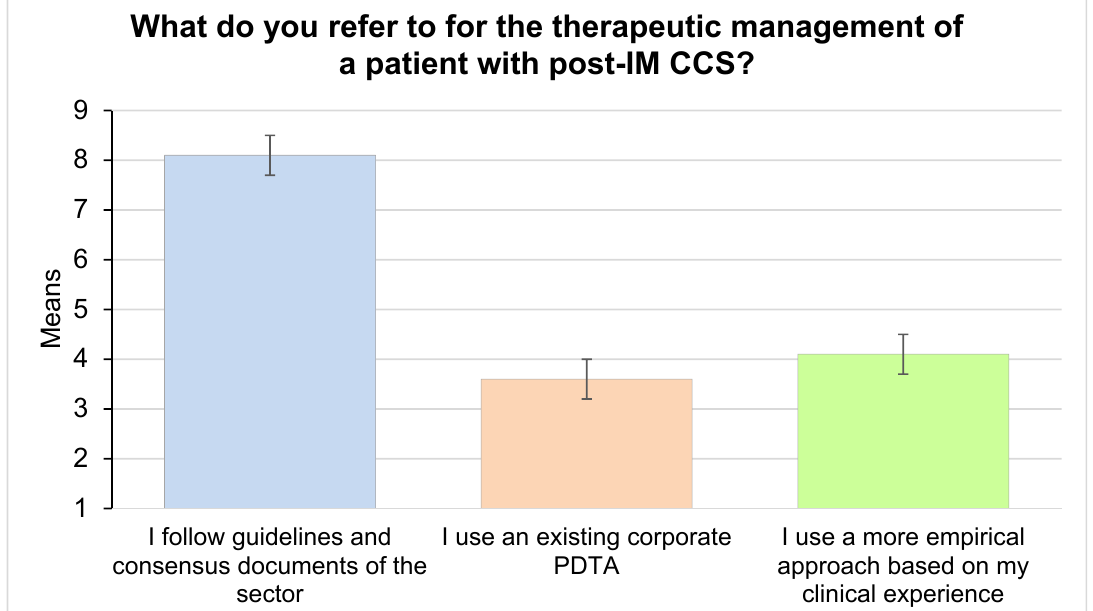
Figure 5. Possible actions aimed at the implementation of follow-up and cure in post-MI CCS pa- tients.